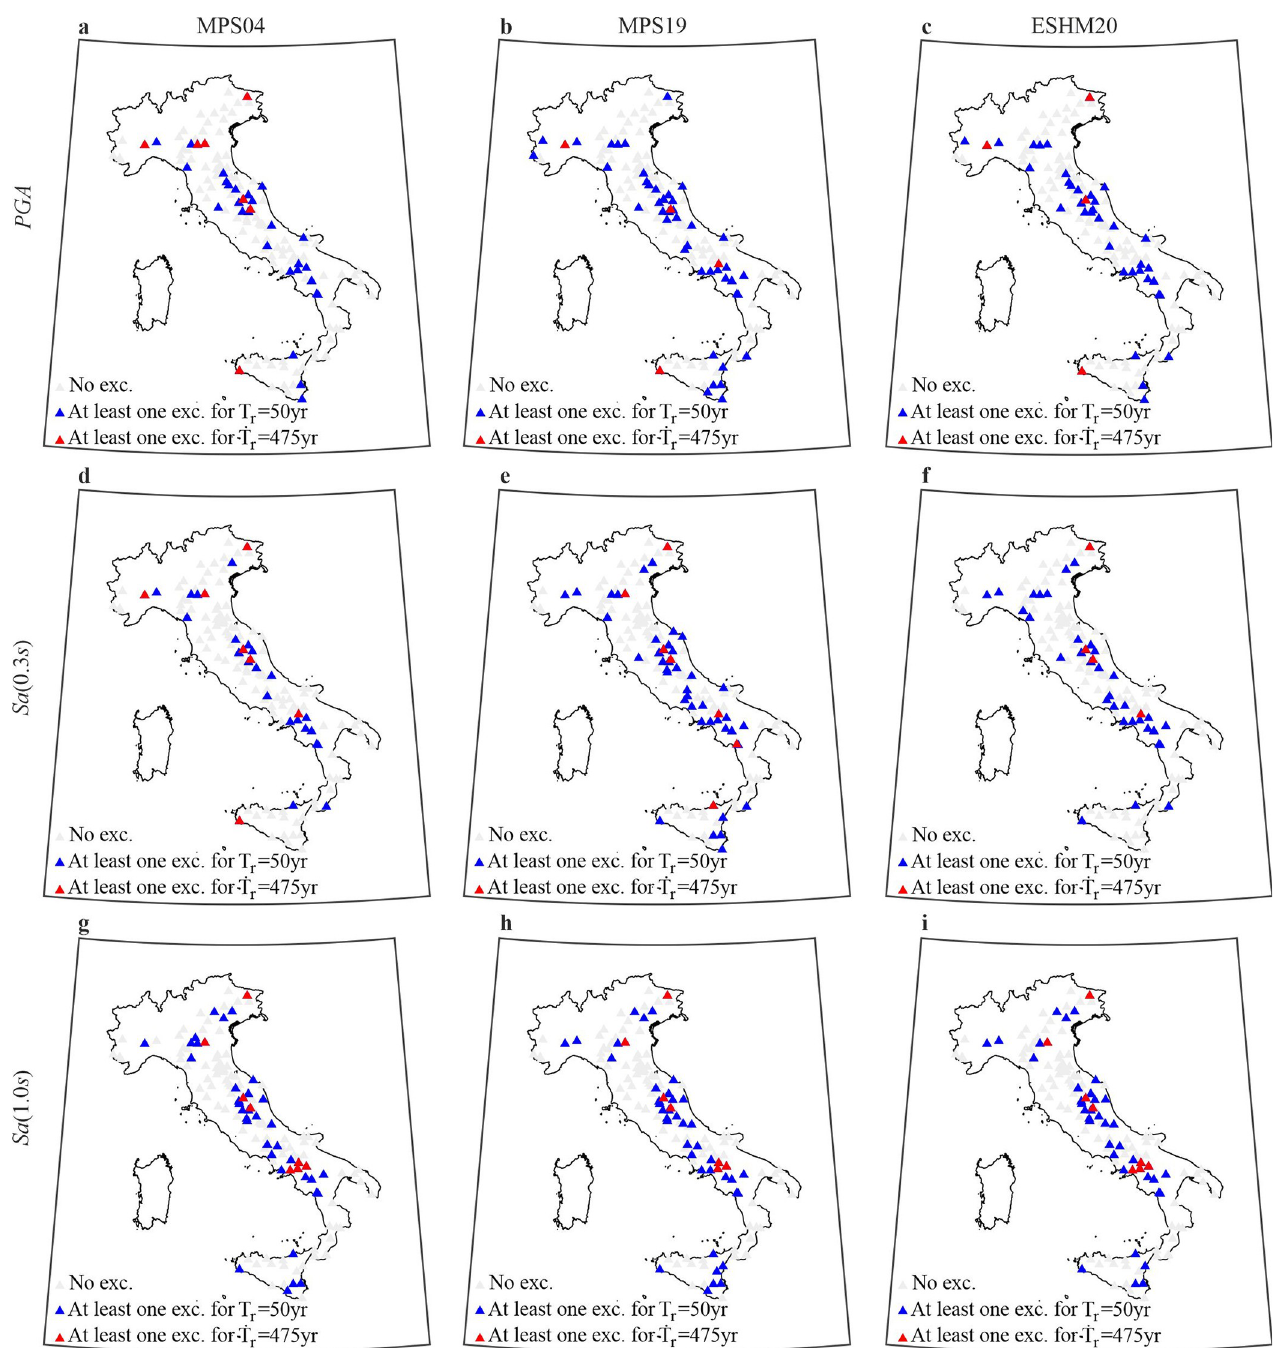
Fig 4. Stations experiencing exceedance. Maps of mainshock exceedance (and non-exceedance) at the stations of the IM thresholds with T r = 50 yr and T r = 475 yr . The panels in the same columns refer to the same model: (a), (d), (g) are from MPS04; (b), (e), (h) are from MPS19; (c), (f), (i) are from ESHM20. The panels in the same row refer to the same IM : (a), (b), (c) are PGA ; (d), (e), (f) are Sa ( 0.3 s );(g), (h), (i) are Sa ( 1.0 s ). The maps were generated using the Matlab mapping toolbox version 4.10 (https://it.mathworks.com/products/mapping.html).